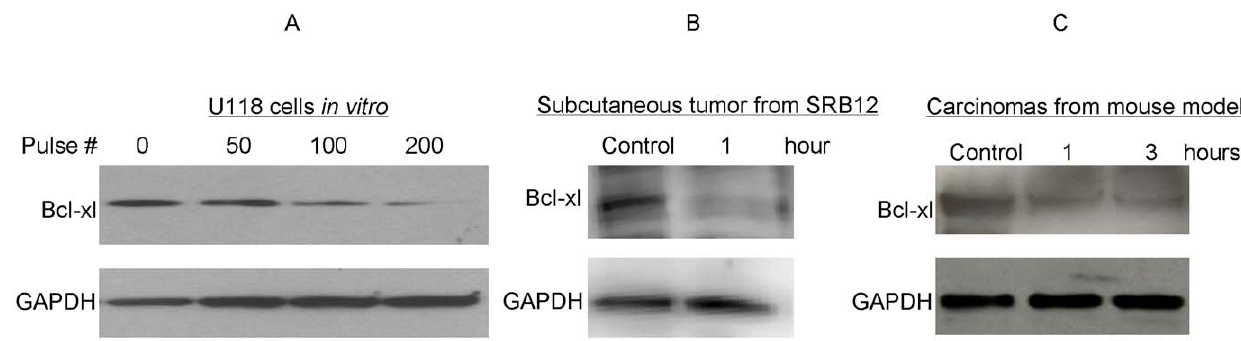
Figure 6. Expression of Bcl-xl invitro and invivo . Western blot analyzed the Bcl-xl expression post nsPEF exposure. Glioblastoma multiforme cell line (U118) was exposed to varying numbers of pulses in vitro [20 ns duration, 50 Hz, and 30 kV/cm) in 1 mm cuvette]. 1 hour post nsPEF exposure, Bcl-xl expression was measured (Panel A ). Squamous carcinoma cell line (SRB-12) was injected subcutaneously into immunocompromised mice. After one week, established tumors were exposed to nsPEF 200 pulses of 14 ns duration, 50 Hz and 40 kV/cm nominal electric field. One hour later, cells were harvested and western blot was performed to measure Bcl-xl expression (Panel B ). Three induced tumors were either untreated or treated with nsPEF (40 kV/cm nominal electric field, 50 Hz, 1.75 mm tip 200p). Protein was extracted from these tumors after 1 and 3 hours, followed by Western blotted and probed with antibody to Bcl-xl (Panel C ). GAPDH was used as loading control. doi:10.1371/journal.pone.0043891.g006 the lesion exposed to at least this number of pulses at multiple sites As a non-uniform electric field is inherent in the 5 needle with the positive electrode applied at approximate 2 mm intervals arrangement used in these experiments combined with the across its surface (see Materials and Methods for treatment details). approximate nature of the electrode placement at multiple sites,